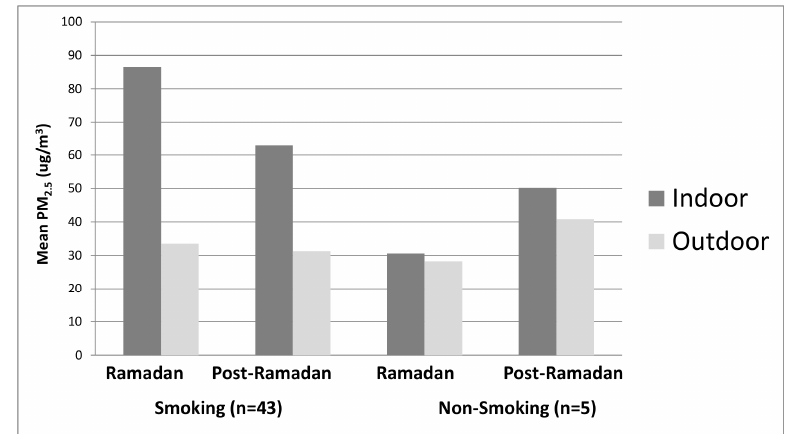
Figure 1. Mean PM 2.5 levels observed in smoking and non-smoking venues during and after